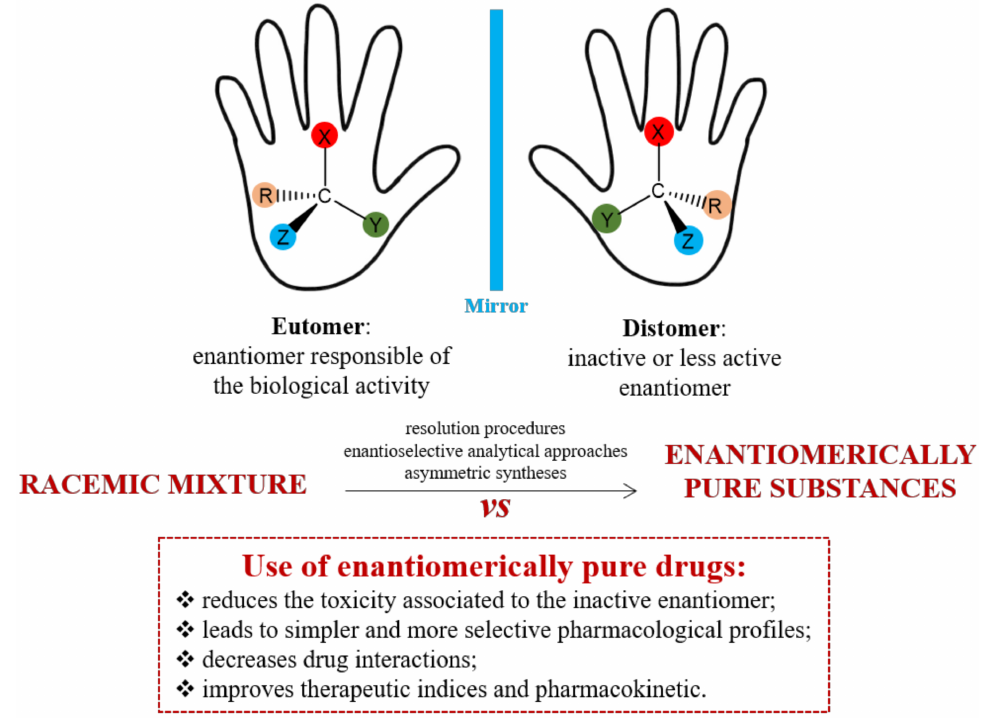
Figure 1. Advantages in the use of single enantiomer